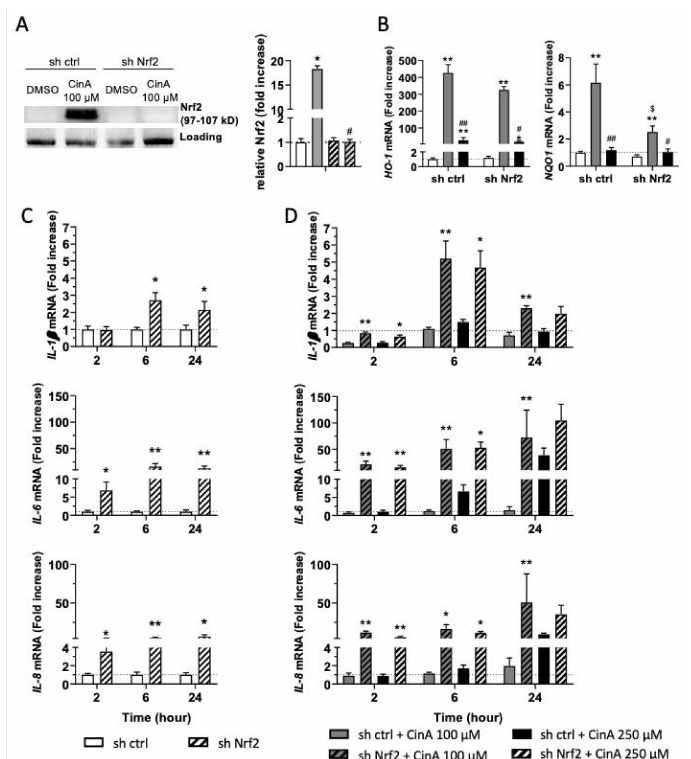
Figure 4. The control of the inflammatory in response to CinA is Nrf2-dependent. KCs were invalidated for Nrf2 by transduction with lentiviral particles to express a short-hairpin RNA targeting Nrf2 (sh Nrf2) or a scrambled short-hairpin (sh ctrl) as the control cells, and the cells were exposed to 100 or 250 µ M of CinA from 2 to 24 h. ( A ) Western blot and relative quantification of Nrf2 after exposure to CinA or DMSO 0.1% as the vehicle control for 6 h. Representative of 4 independent experiments. ( B ) mRNA levels of HO-1 and NQO1 measured by RT-qPCR after 6 h of exposure to 100 or 250 µ M of CinA and DMSO 0.1% as the vehicle control. ( C ) mRNA level of inflammatory cytokines IL-1 β , IL-6, and IL-8 determined by RT-qPCR after 2, 6, and 24 h of culture without any stimulation. ( D ) mRNA levels of inflammatory cytokines IL-1 β , IL-6, and IL-8 determined by RT-qPCR after 2, 6, and 24 h of exposure to 100 or 250 µ M of CinA. Data represent the results of 5 independent experiments and are expressed as the mean ± SEM. ( A , B ) * Represents the statistical difference between CinA and vehicle-treated cells, # represents the statistical difference between 100 µ M and 250 µ M-treated cells, and $ represents the statistical difference between sh ctrl and sh Nrf2 cells. ( C , D ) * Represents the statistical difference between sh ctrl and sh Nrf2 cells. *, # p -value < 0.05 and **, ## p -value < 0.01 (Mann–Whitney